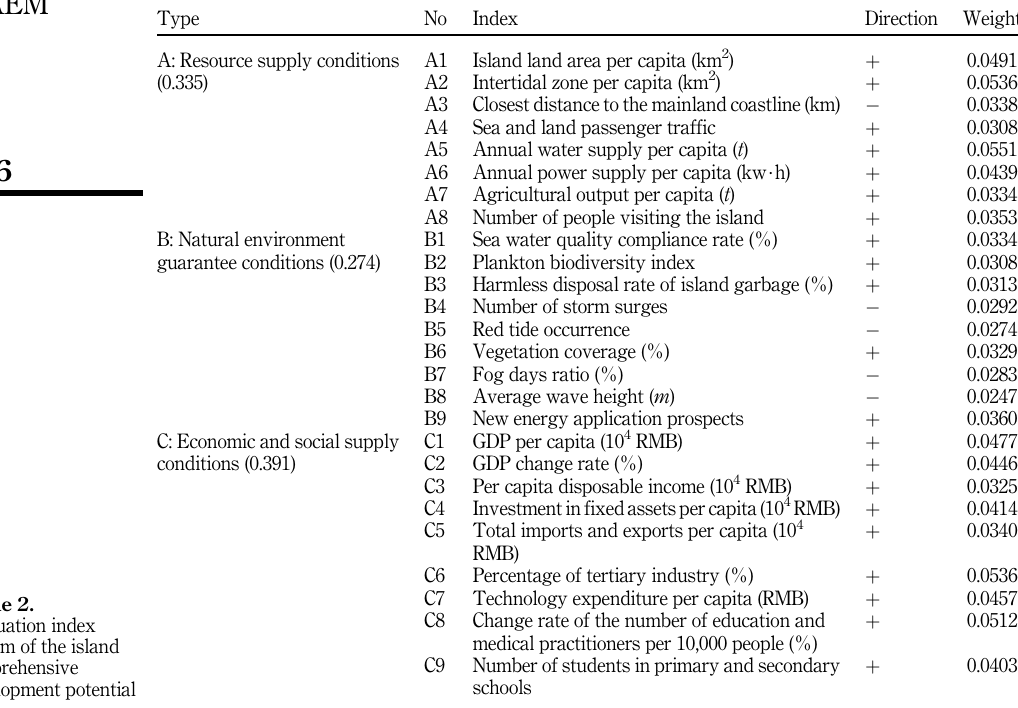
Table 2. Evaluation index system of the island comprehensive development